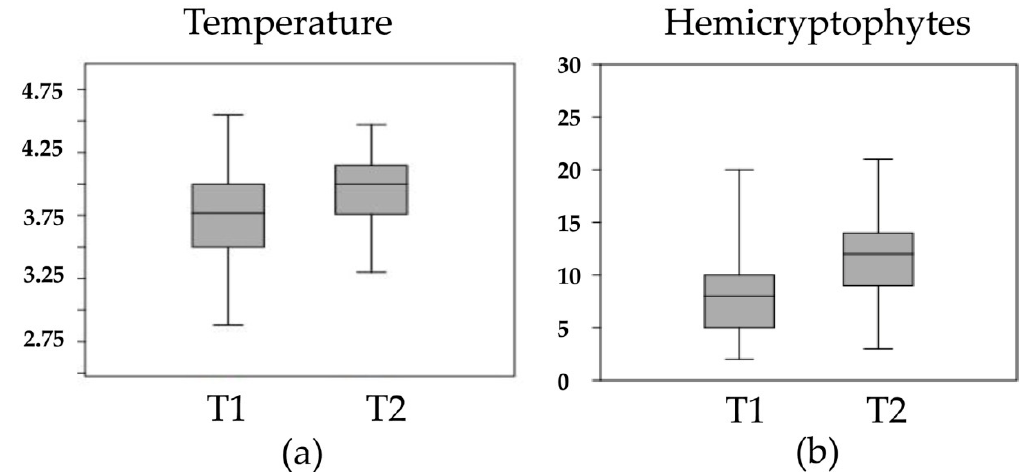
Figure 3. Box plots comparing ( a ) the Ellenberg ecological value (temperature; p = 0.0143) and ( b ) frequency